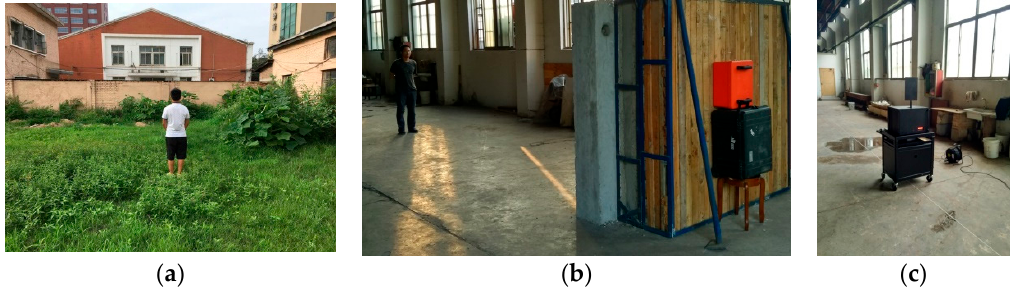
Figure 2. The conducted experiments in through-wall conditions ( a ) outdoors; ( b ) indoors; and ( c ) on the actuator.